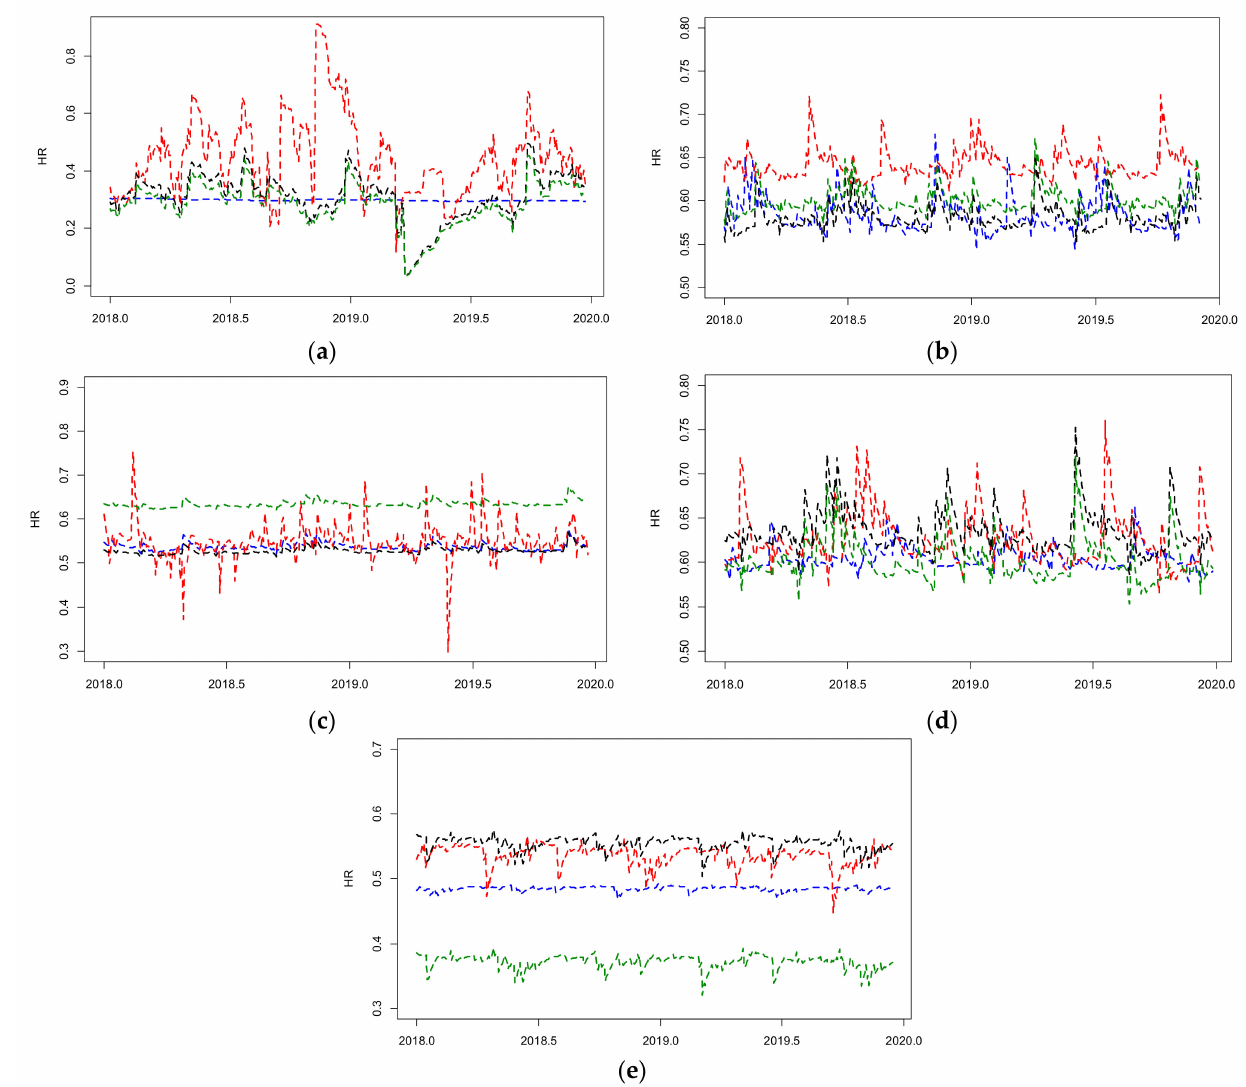
Figure 3. Time-varying hedge ratio measurements. Note: the hedge ratio measure plotted is the weighted average × Pr ( s t = 1 | Ω t )) + ( HR × Pr ( s t = 2 | Ω t )) with weights given by the smoothed probability of two regimes, ( HR t , s t = 2 t , s t = 1 i.e., Pr ( s t = 1 | Ω t ) and Pr ( s t = 2 | Ω t ) : ( a ) CAD, ( b ) CNY, ( c ) EUR, ( d ) GBP, and ( e )